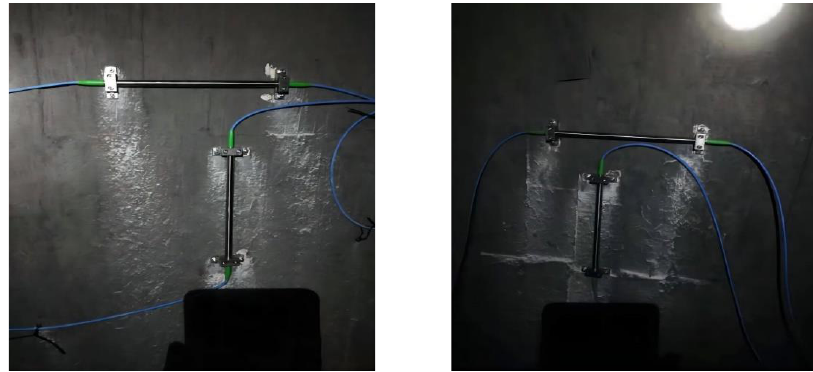
Figure 10. Field layout and installation of FBG sensors.